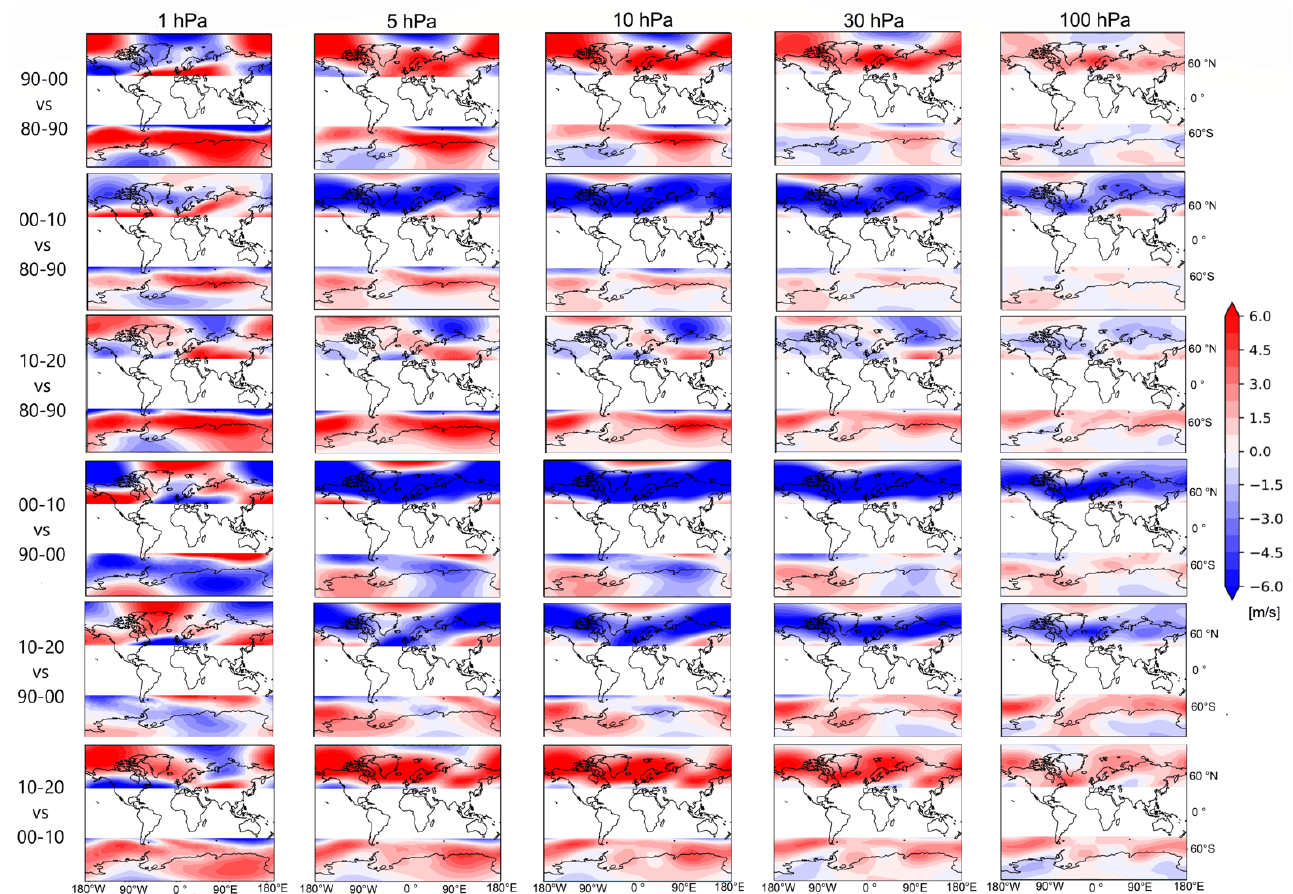
Figure 7. Difference of zonal wind climatology (m/s) between decades for 1, 5, 10, 30 and 100 hPa using ERA5 reanalysis.